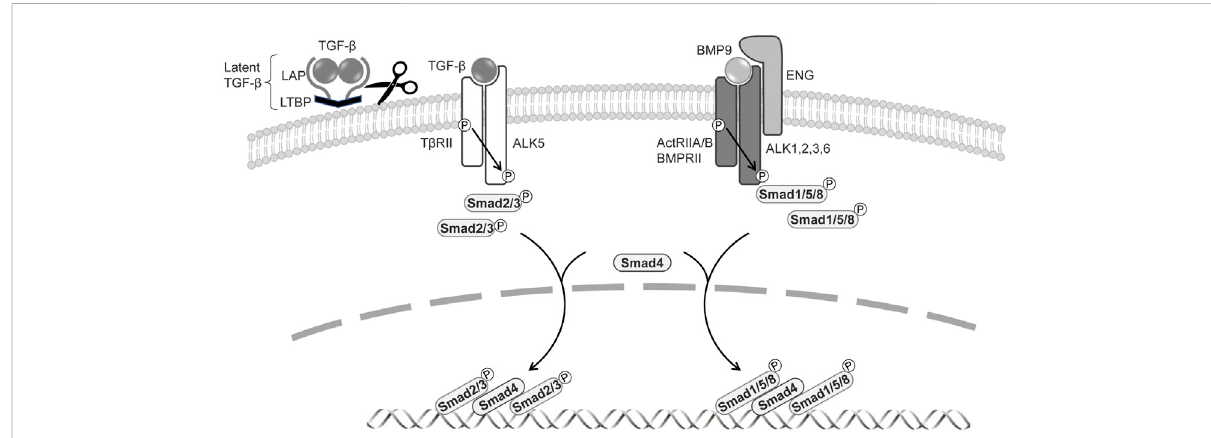
FIGURE 1 SignaltransductionbyTGF- β familymembersinBECsandLECs.Thesignalingismediatedthroughaheteromericcomplexofspeci fi ctypeIand type II serine/threonine kinase receptors. TGF- β is produced as a precursor by a single gene and then proteolytically cleaved into three fragments: latent TGF- β -binding protein (LTBP), an N-terminal latency-associated protein (LAP), and an active C-terminal cytokine region. Activated TGF- β interacts with T β RII and ALK5. BMPs signal via ActRIIA/B, BMPRII, and type I receptors ALK1, 2, 3, and 6. The co-receptor endoglin and ALK1, exclusively expressed on endothelial cells, are involved in BMP9 signaling. TGF- β s phosphorylate of Smad2 and Smad3, and BMPs induce phosphorylation of Smad1, 5, and 8. Activated Smads form heteromeric complexes with Smad4, which translocate to the nucleus, where they regulate the target gene